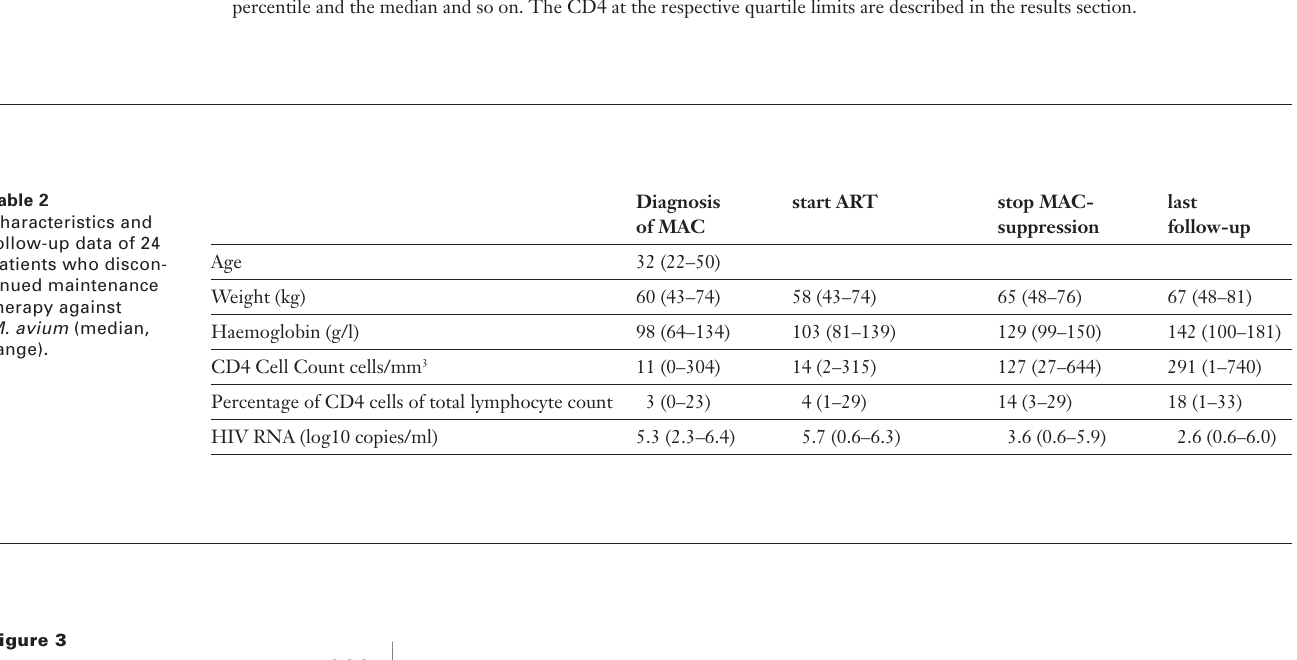
Figure 3 Absolute CD4 counts of 24 patients discon- tinuing maintenance therapy against M. avium